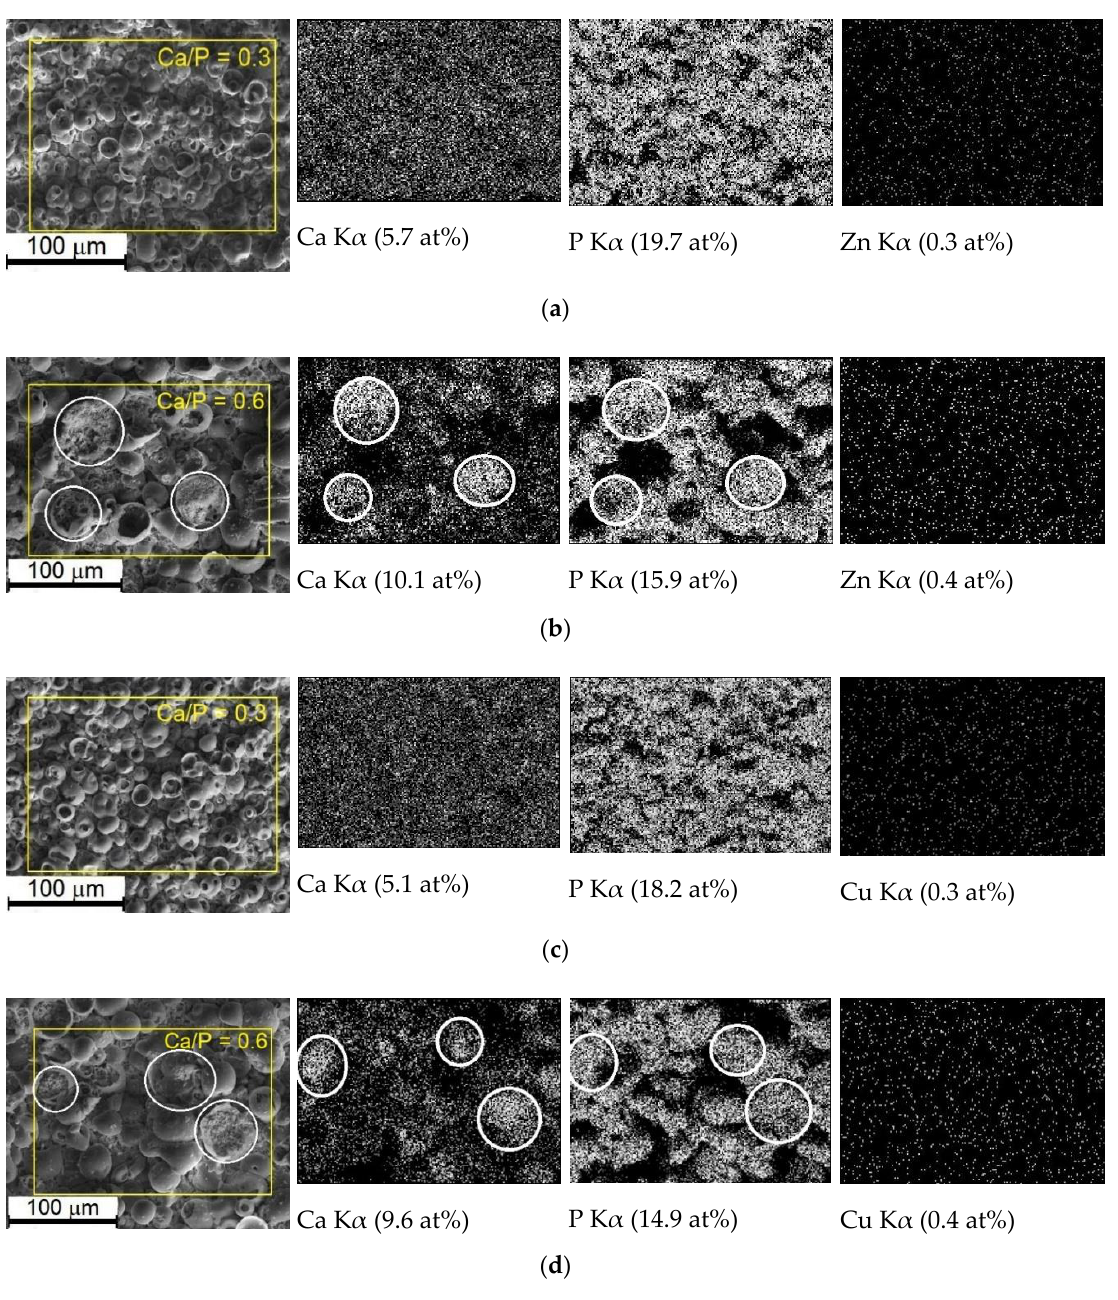
Figure 7. Typical SEM images and EDX grey-level maps of the Ca, P, Zn and Cu concentrations (marked with white color) in the Zn-CaP ( a , b ) and Cu-CaP ( c , d ) coatings deposited on Ti at applied voltages of 200 V ( a , c ) and 300 V ( b , d ).